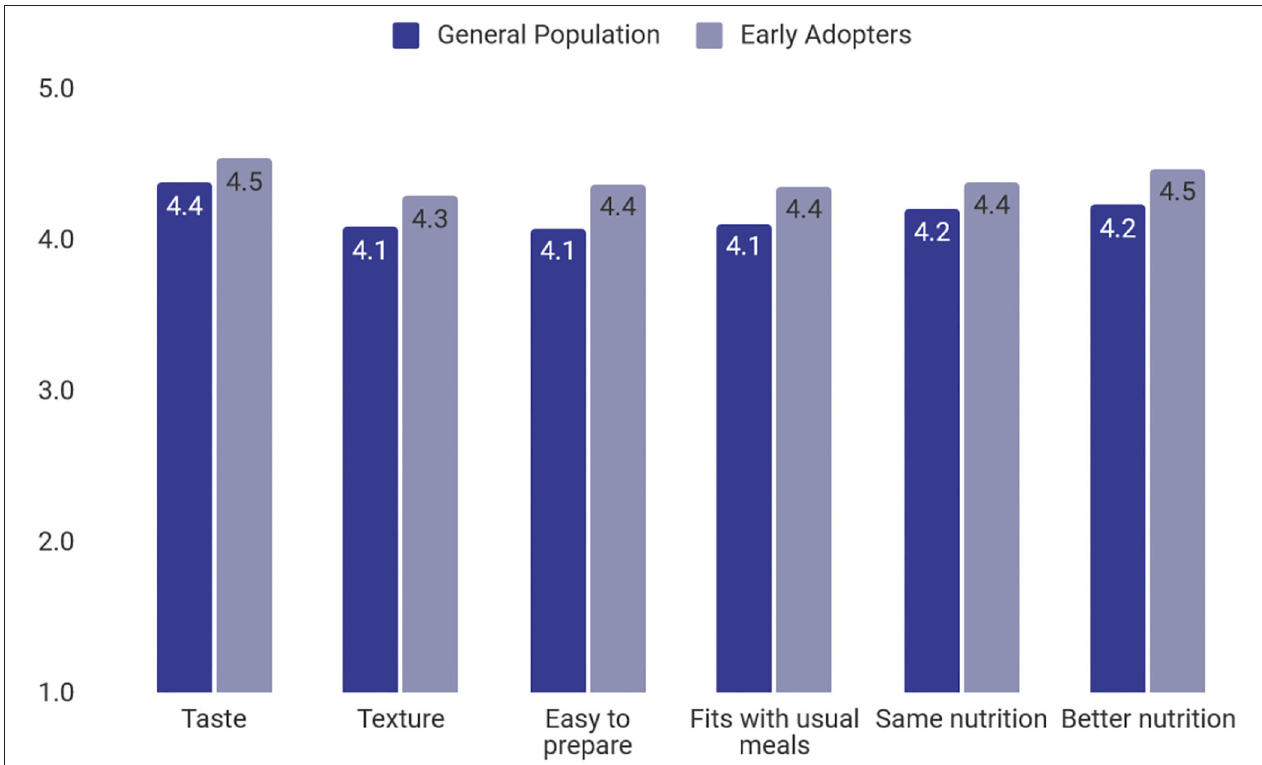
FIGURE 12 | Mean importance of characteristics of cultivated meat in the general population and among early